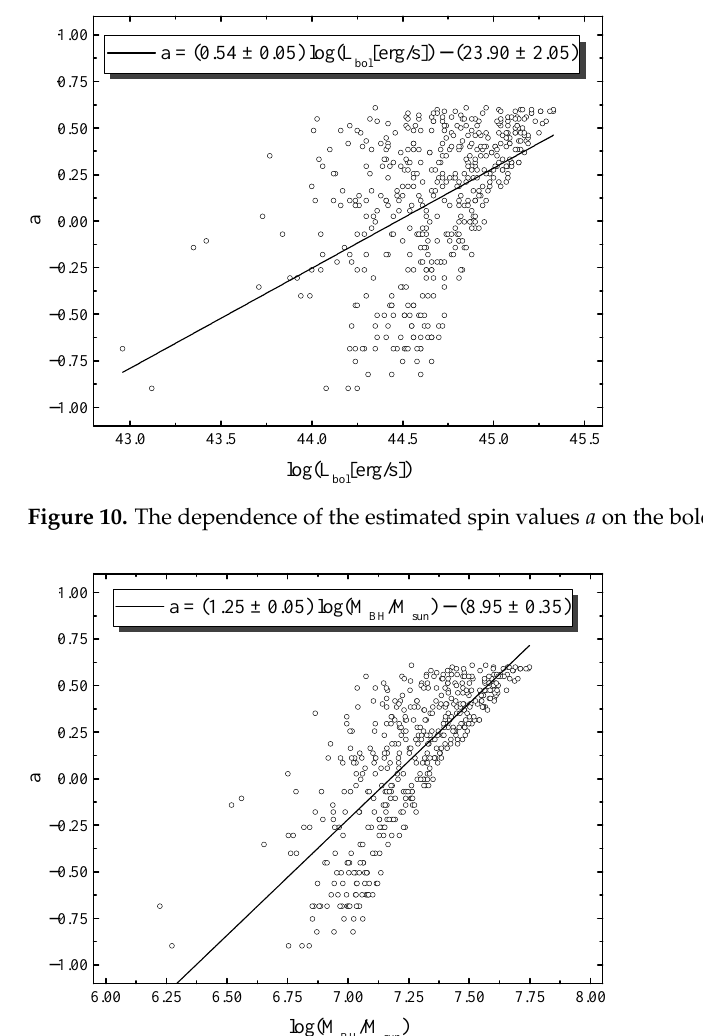
Figure 9. The normalized distributions of the estimated spins for Seyfert 1 [21] and NLS1 (this work).